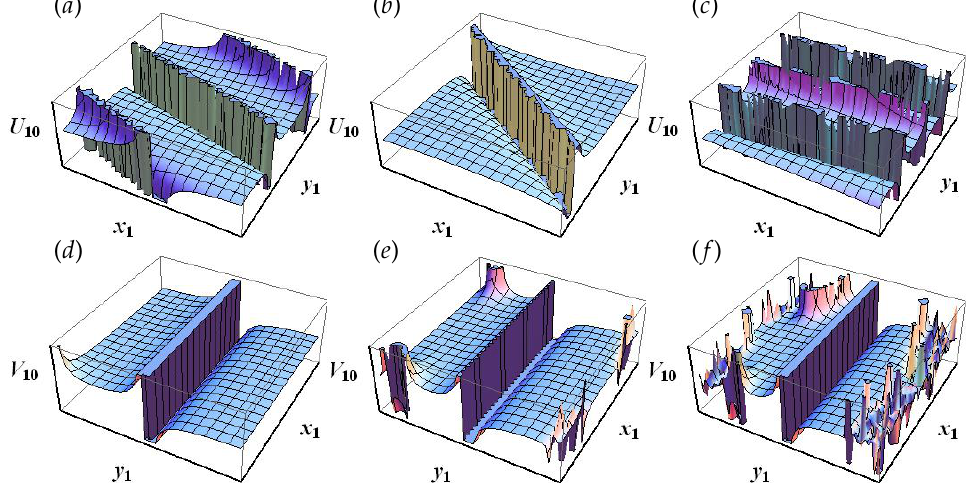
Figure 1. ( a – c ) Three-dimensional plots of U 10 ( t , x 1 , y 1 ) without the noise effect, when t = 1, 1.5 and